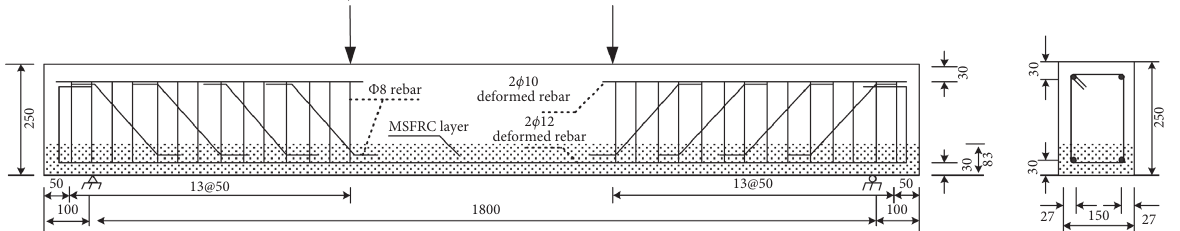
Figure 11: The RC beam partially reinforced by MSFRC.